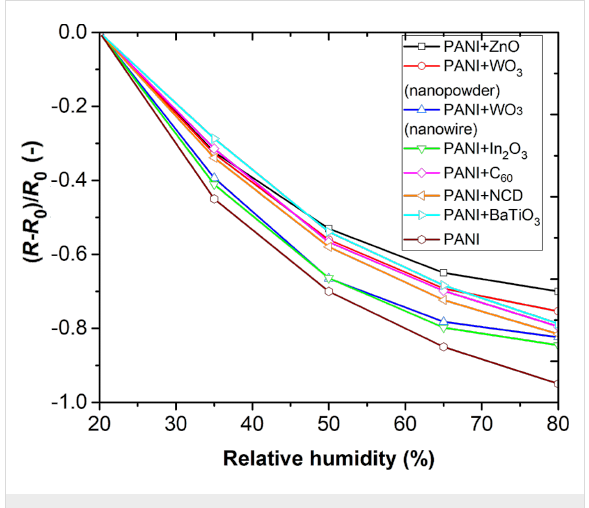
Figure 10: RH dependences of the sensing layers.